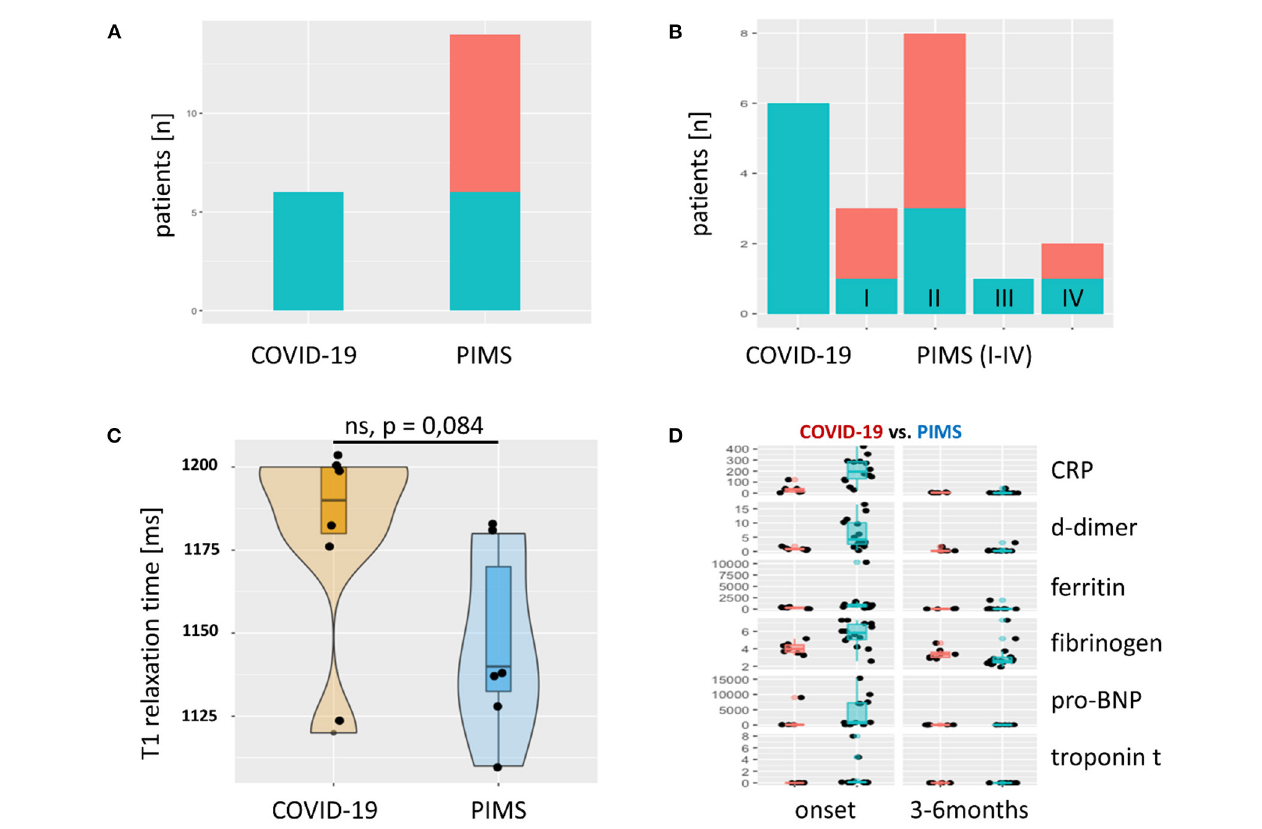
FIGURE2 Late Gadolinium Enhancement (LGE) and T1 relaxation times and laboratory results. (A) The absolute frequency of LGE as bar graph. LGE (green) was found in every severe acute COVID-19 patient. In the group of patients with PIMS, we observed LGE in 6/14 (43%). Red = unaffected patients. In (B) , the PIMS group was divided into four subgroups: (I) Kawasaki-like without shock symptoms, (II) Kawasaki-like with shock, (III) PIMS without shock, and (IV) PIMS with shock. LGE could not be attributed to one of these four subgroups, although a trend toward group II Kawasaki with shock symptoms was seen. T1 relaxation time in areas of the myocardium with LGE is shown in (C) as violin plots with superimposed scatter plots. This shows a prolongation of relaxation time above the norm ( < 1,100ms, determined in 20 healthy subjects) in both groups. Patients with severe acute COVID-19 showed an even more pronounced prolongation of T1 relaxation time than patients with PIMS. There was no significant difference between the two groups ( p = 0.084). Solid line = median. Markers of inflammation and myocardial damage of patients with COVID-19 (red) and PIMS (blue) at the time of disease onset and last visit are compared in (D) . All markers are more elevated in PIMS group but normalize completely until the last visit after 3–6 months. CRP, C-reactive protein [mg/L]; d-dimer [mg/L fibrinogen equivalent units], ferritin [ng/L], fibrinogen [g/L], pro-BNP, pro-brain natriuretic peptide [pg/mL], troponin t